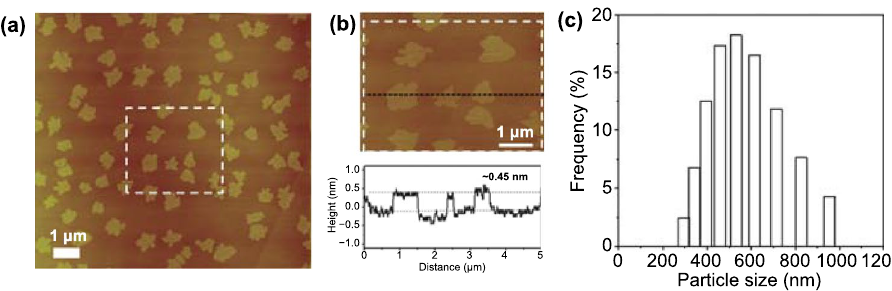
Fig. 2 AFM image of g‑C 3 N 4 –m. a The g‑C 3 N 4 –m monolayers dispersed on the freshly‑cleaved muscovite mica substrate. b The thickness of g‑C